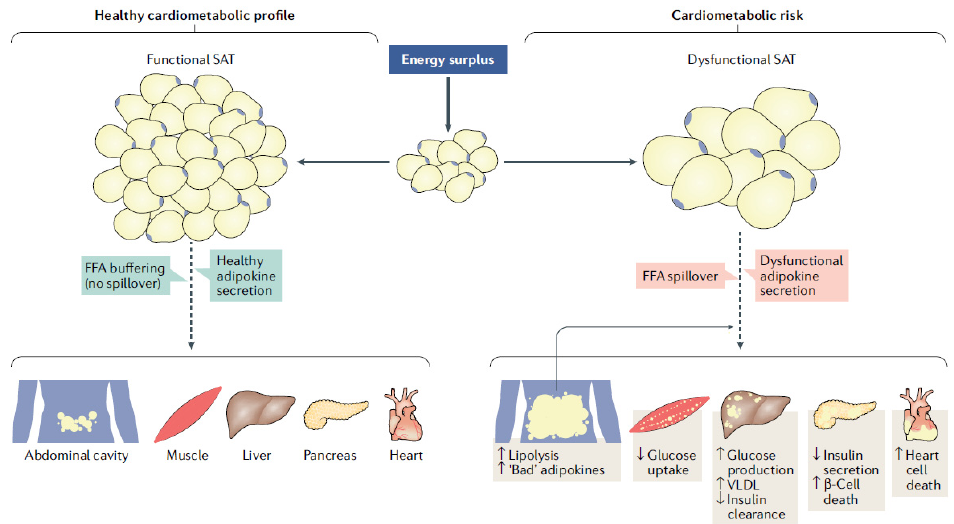
Figure 1. Cardiometabolic risk from dysfunctional adipose tissue is associated with altered adipokines and proinflammatory cytokines production which leads to a series of metabolic dysfunctions. Reproduced with permission from: Ross et al., 2020.